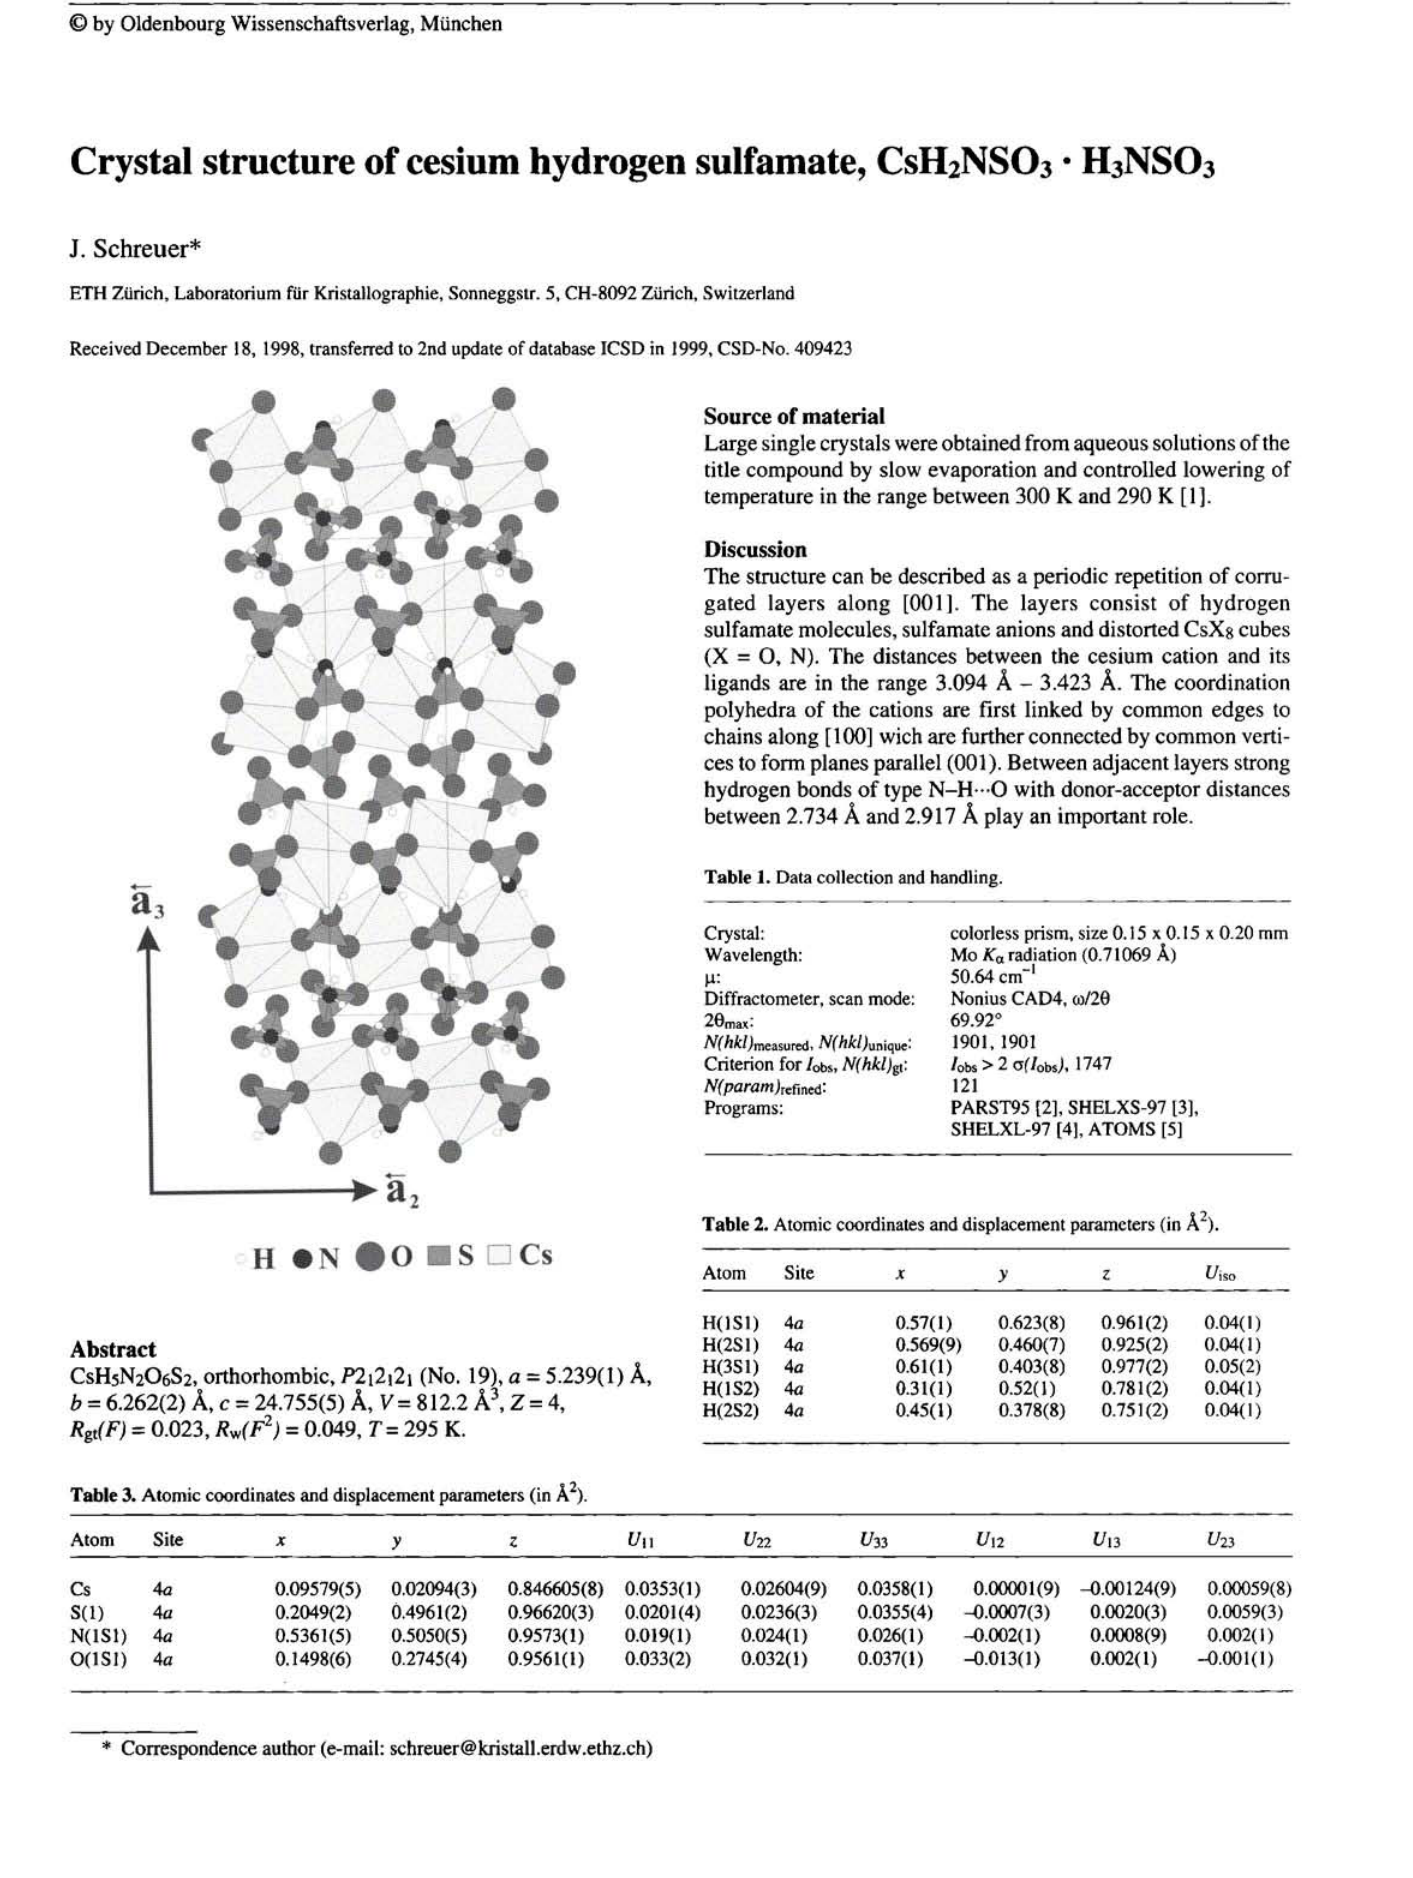
Table 3. Atomic coordinates and displacement parameters (in Â 2 ).